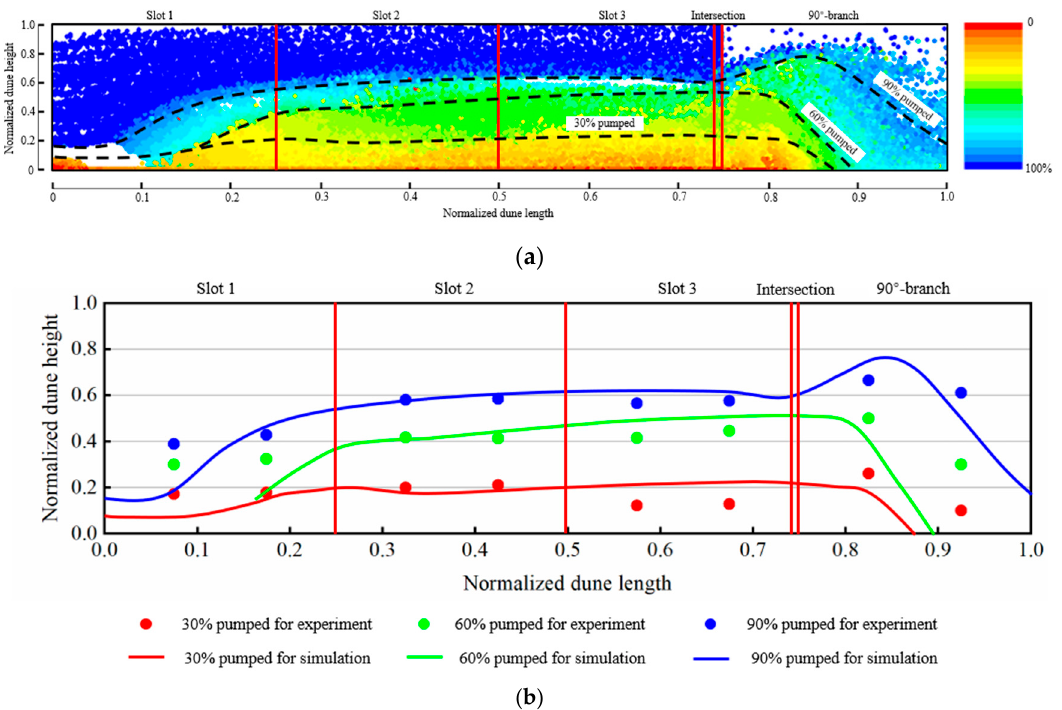
Figure 11. Simulation and experimental results of normalized dune height for case 4, ( a ) Dune geometries in different pumping stages, ( b ) comparisons between simulation and experimental results.